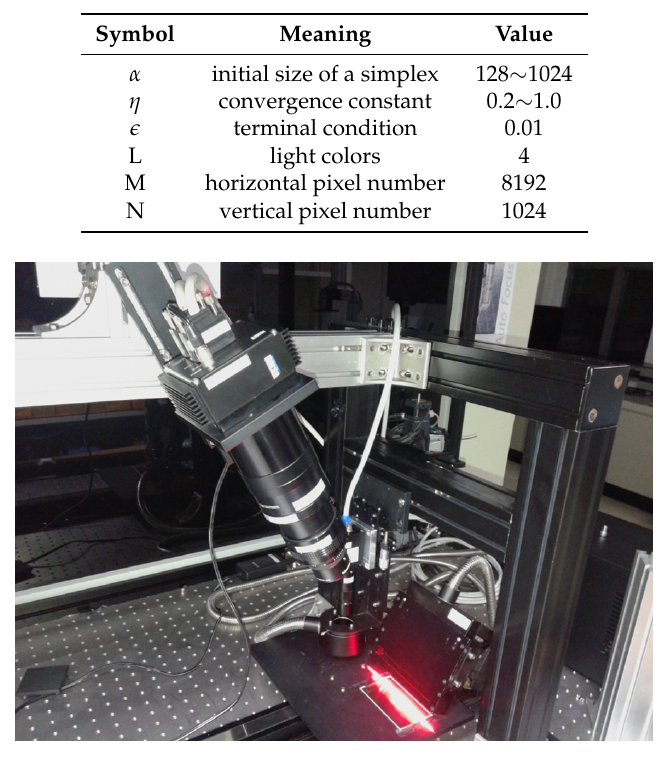
Figure 4. Experimental setup for inspecting an AMOLED panel using a mixed color